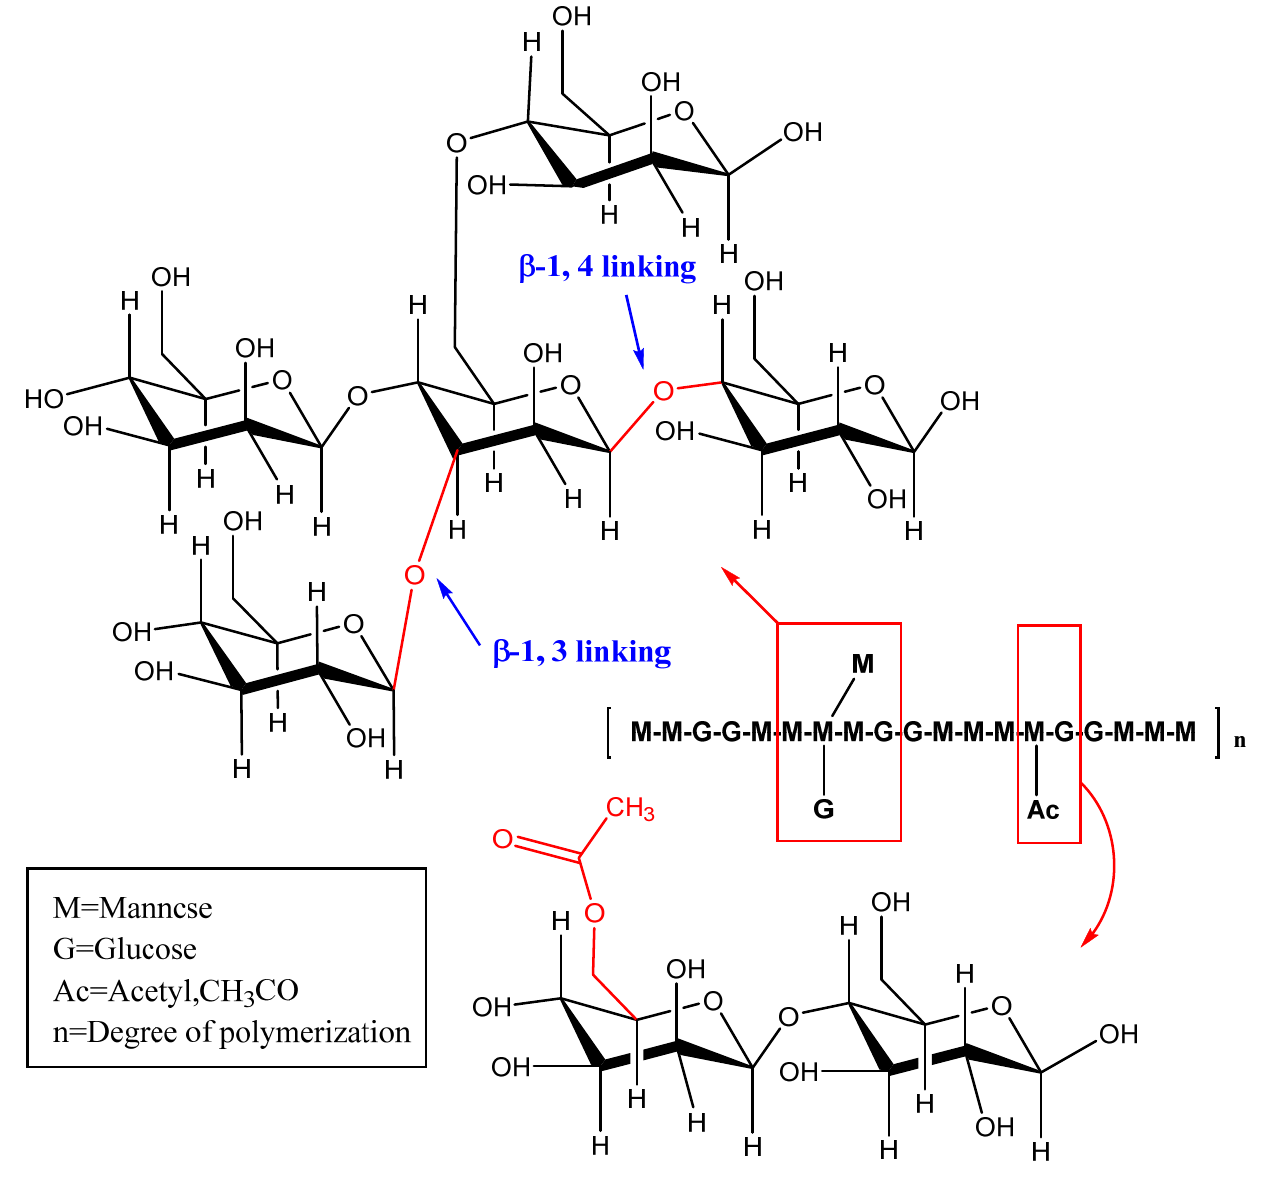
Figure 3. Schematic diagram of KGM structure.